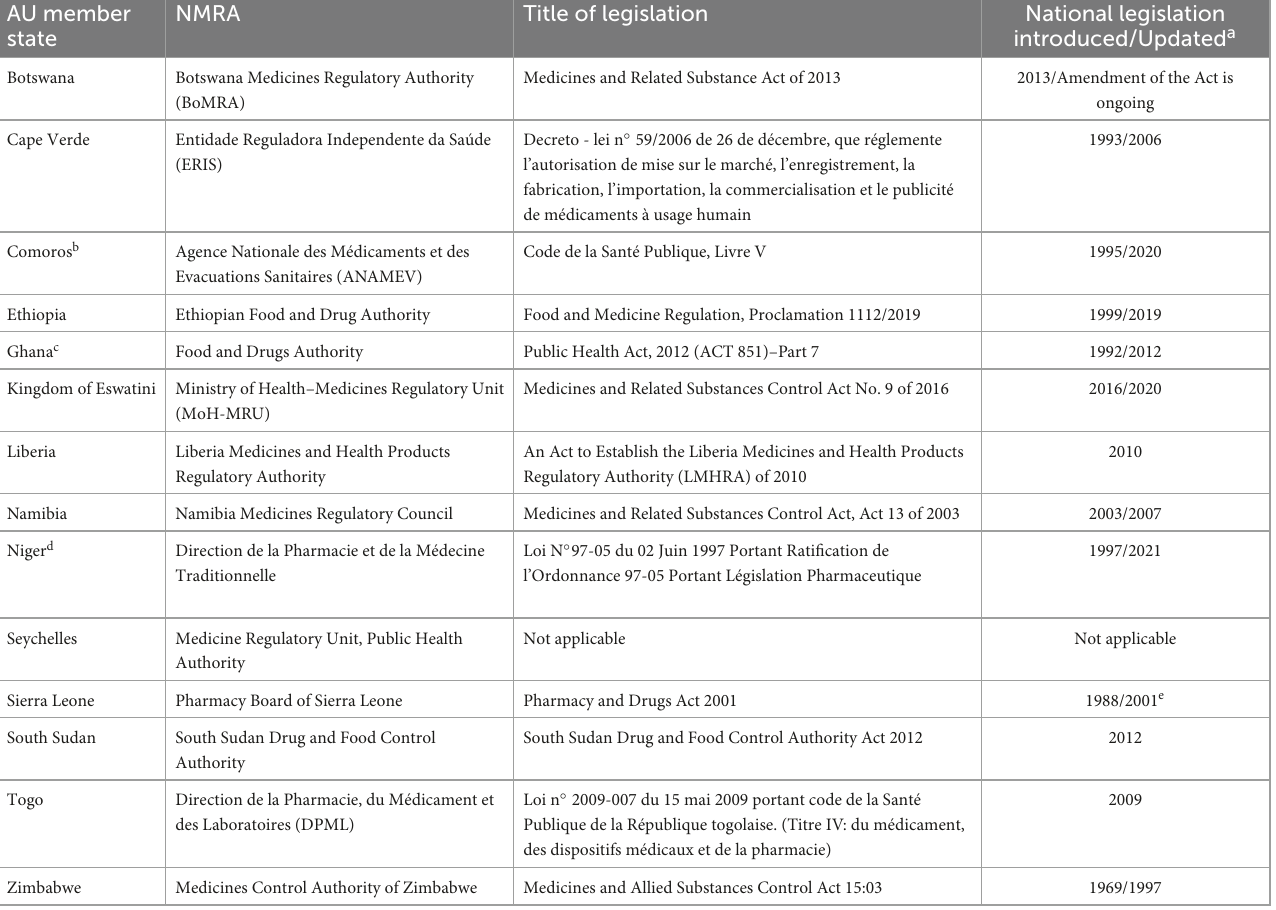
TABLE 2 Study countries that have not domesticated the AU Model Law ( n =